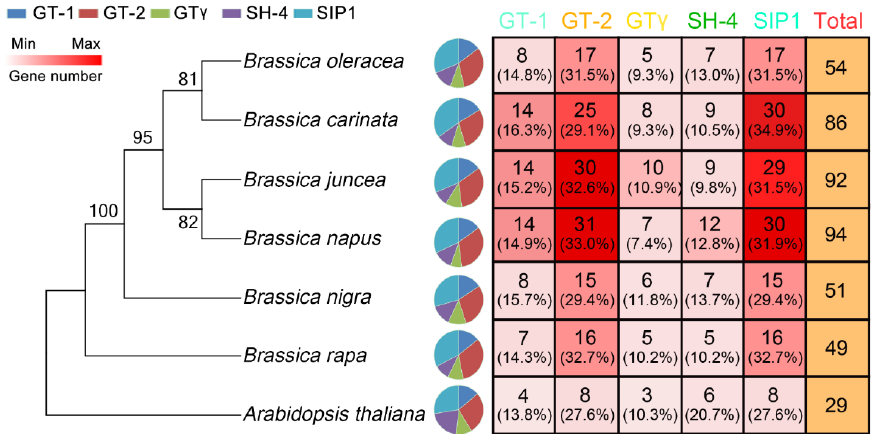
Figure 7. Clade distribution of TH genes in Arabidopsis , B. rapa , B. nigra , B. oleracea , B. juncea , B.